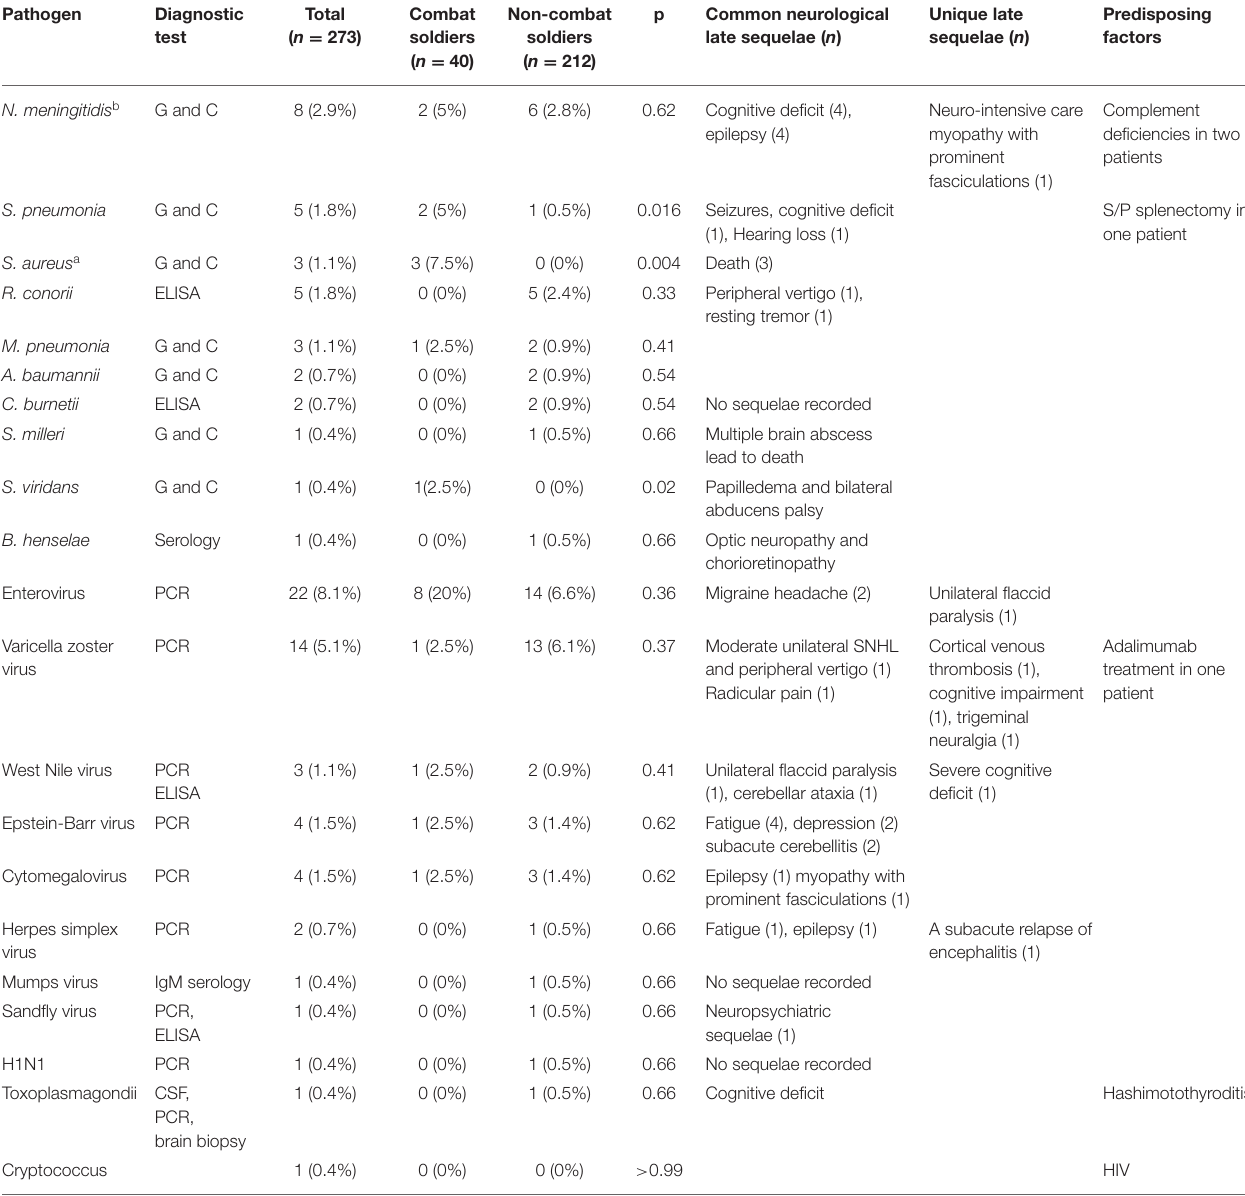
TABLE 2 | Known pathogens and their